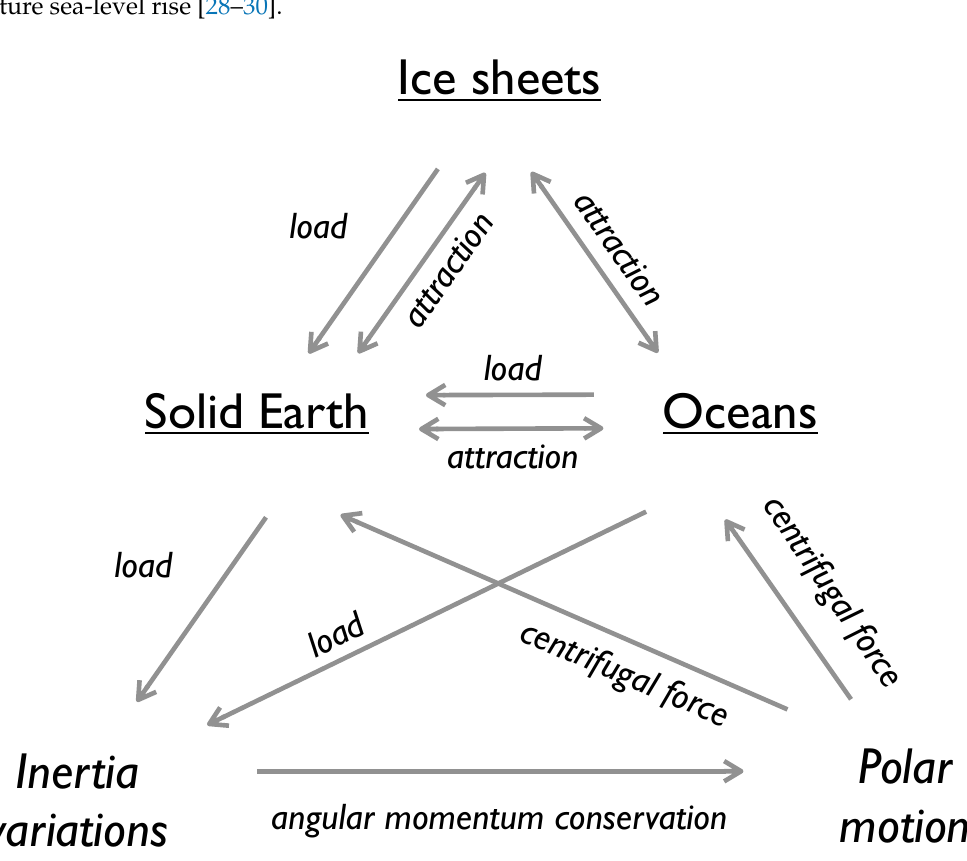
Figure 2. The top part of the triangle shows the elements that are perpetually interacting in the SLE (the solid Earth, the ice sheets and the oceans) through surface loading and mutual gravitational attraction. The bottom part qualitatively shows how Earth rotational effects are coming into